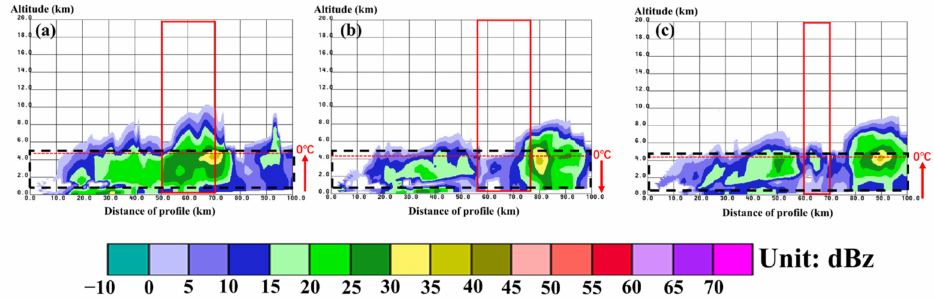
Figure 7. 21 May 2018, ( a ) 13:18 of V1, ( b ) 14:18 of V2, ( c ) 14:42 of V3. The red rectangle box is the aircraft detection area.